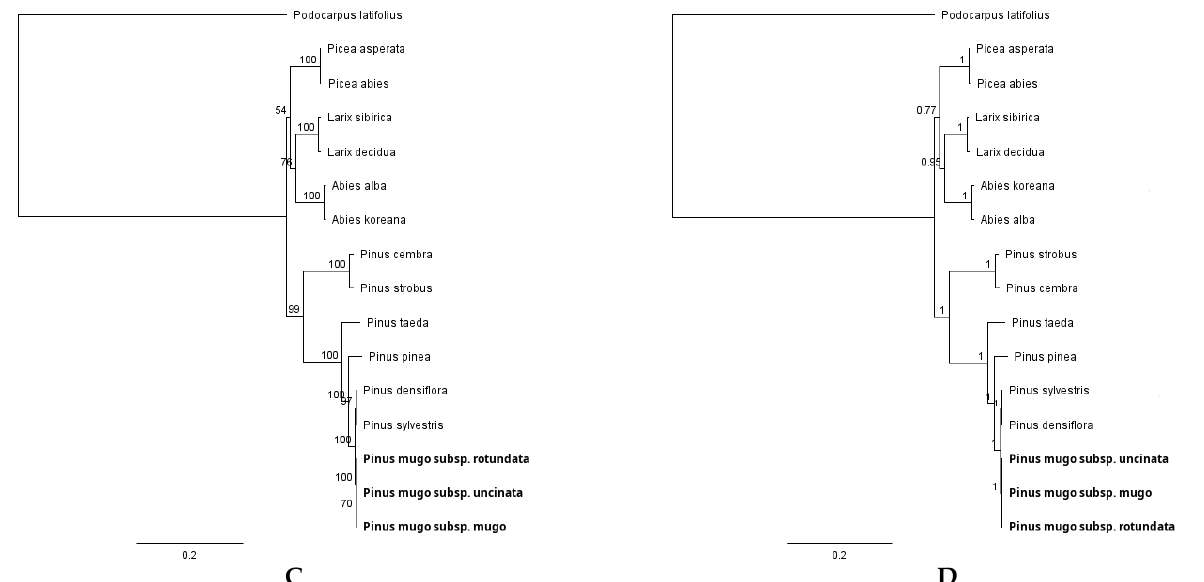
Figure 5. Phylogenetic relationships between sixteen conifers taxa based on complete sequences of chloroplast genomes ( A ) and ( B ) inferred from ML and BI analyses, respectively, and only on ycf1 ( C ) and ( D ) also inferred from ML and BI analyses, respectively.